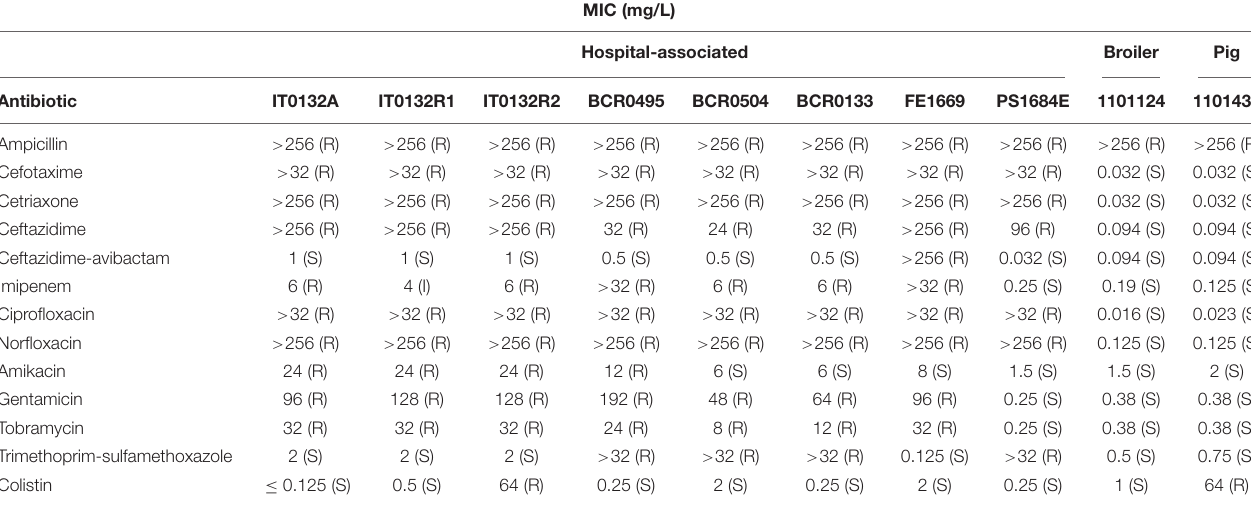
TABLE 1 | Minimum inhibitory concentrations (MIC) and interpretation for K. pneumoniae ST101 of human and animal origin determined by ETEST R (cid:13) with the exception of colistin MIC which were determined using the broth microdilution method. MIC (mg/L) Hospital-associated Broiler Pig